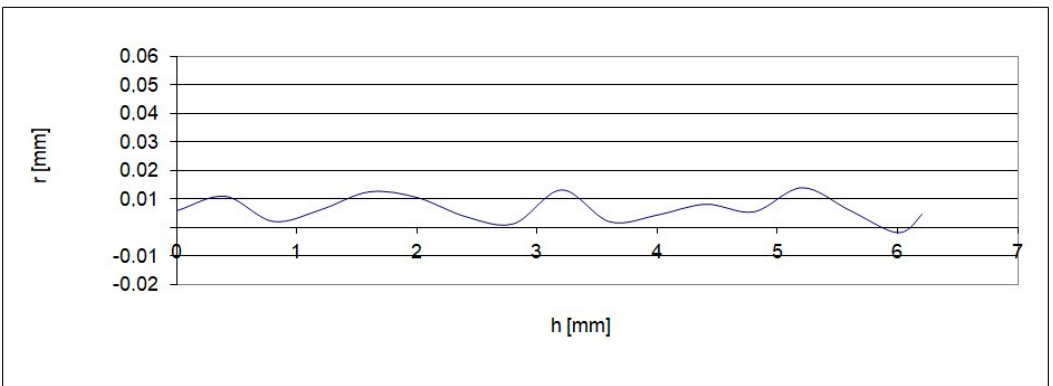
Figure 16. CMM (Coordinate Measuring Machine) measuring report.